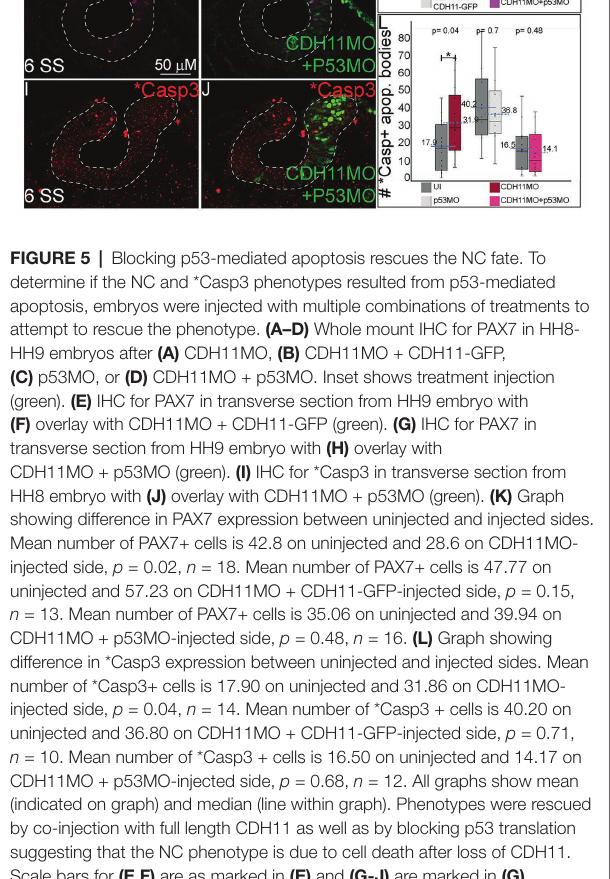
by co-injection with full length CDH11 as well as by blocking p53 translation suggesting that the NC phenotype is due to cell death after loss of CDH11. Scale bars for (E,F) are as marked in (E) and (G-J) are marked in (G)